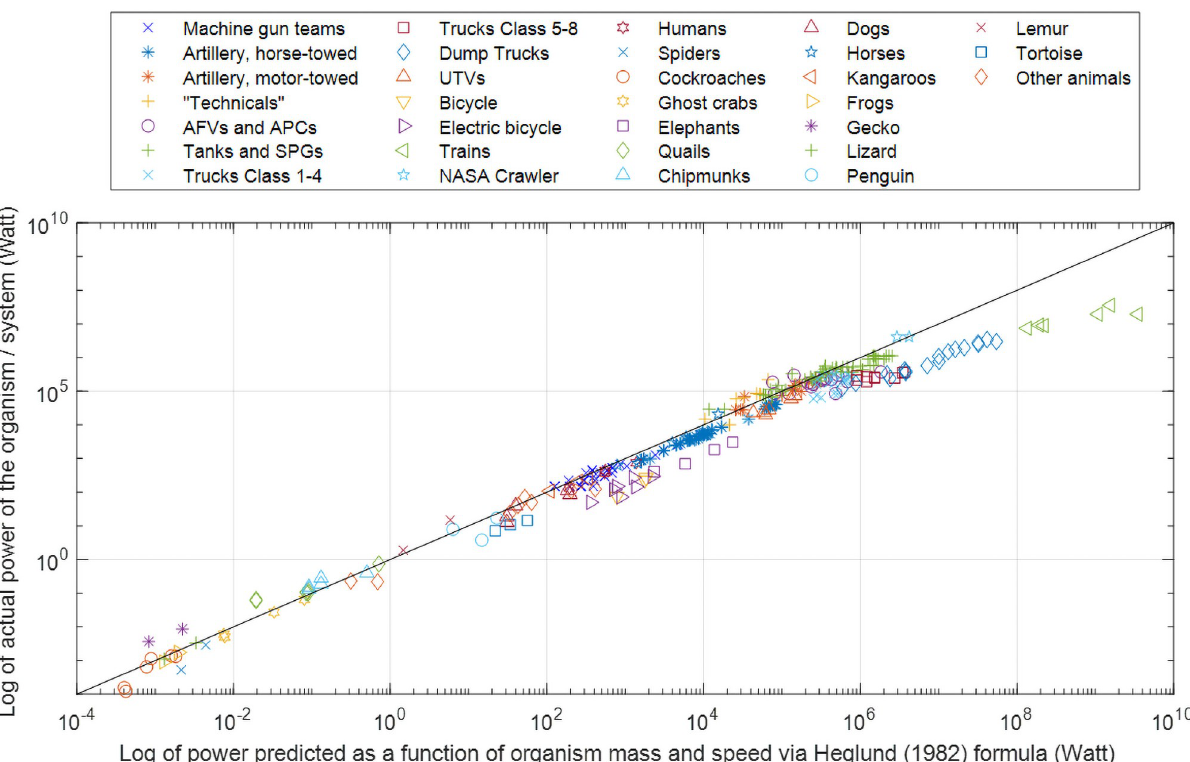
Fig 1. Comparison of mechanical power predicted by the Heglund formula vs. the actual measured or specified power. The diagonal line illustrates the close agreement of predicted vs. actual values. For organisms and systems with a weight of < 35,000 kg, R2 is 0.98 (on the log 10 basis; throughout the paper log refers to log 10